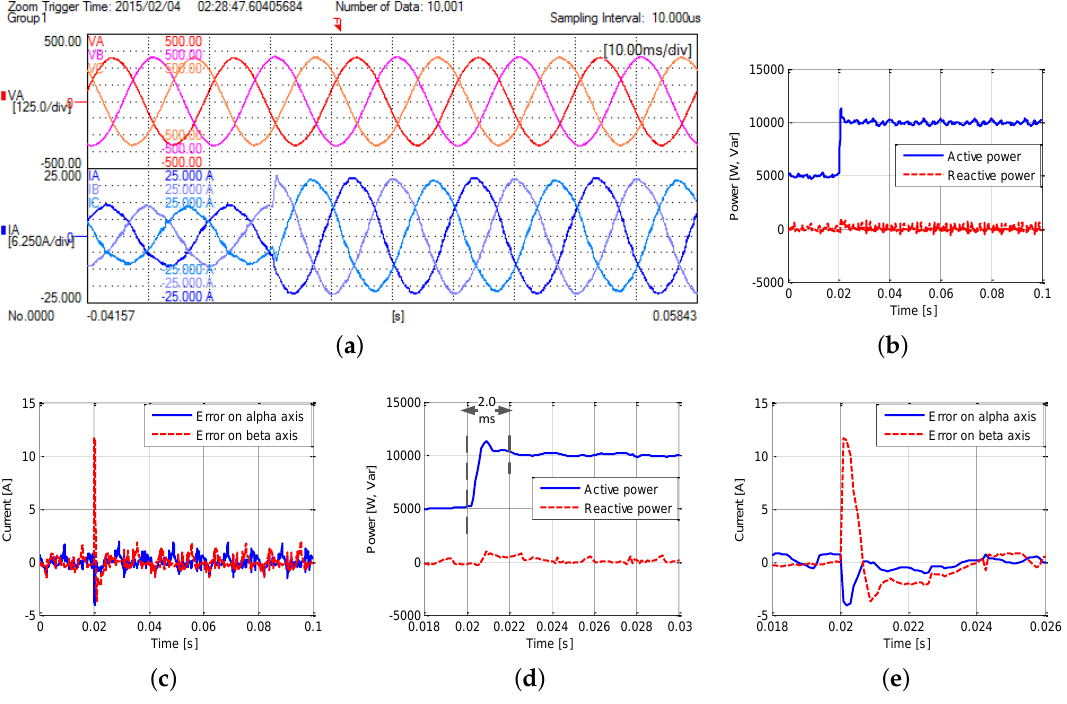
Figure 12. Experimental performance of the 10-kW system when active power reference jumps from 5 kW to 10 kW: ( a ) grid voltage and injected current; ( b ) instantaneous active and reactive power injection; ( c ) current control error on the α and β axis; ( d ) zoom-in view of ( b ); and ( e ) zoom-in view of ( c